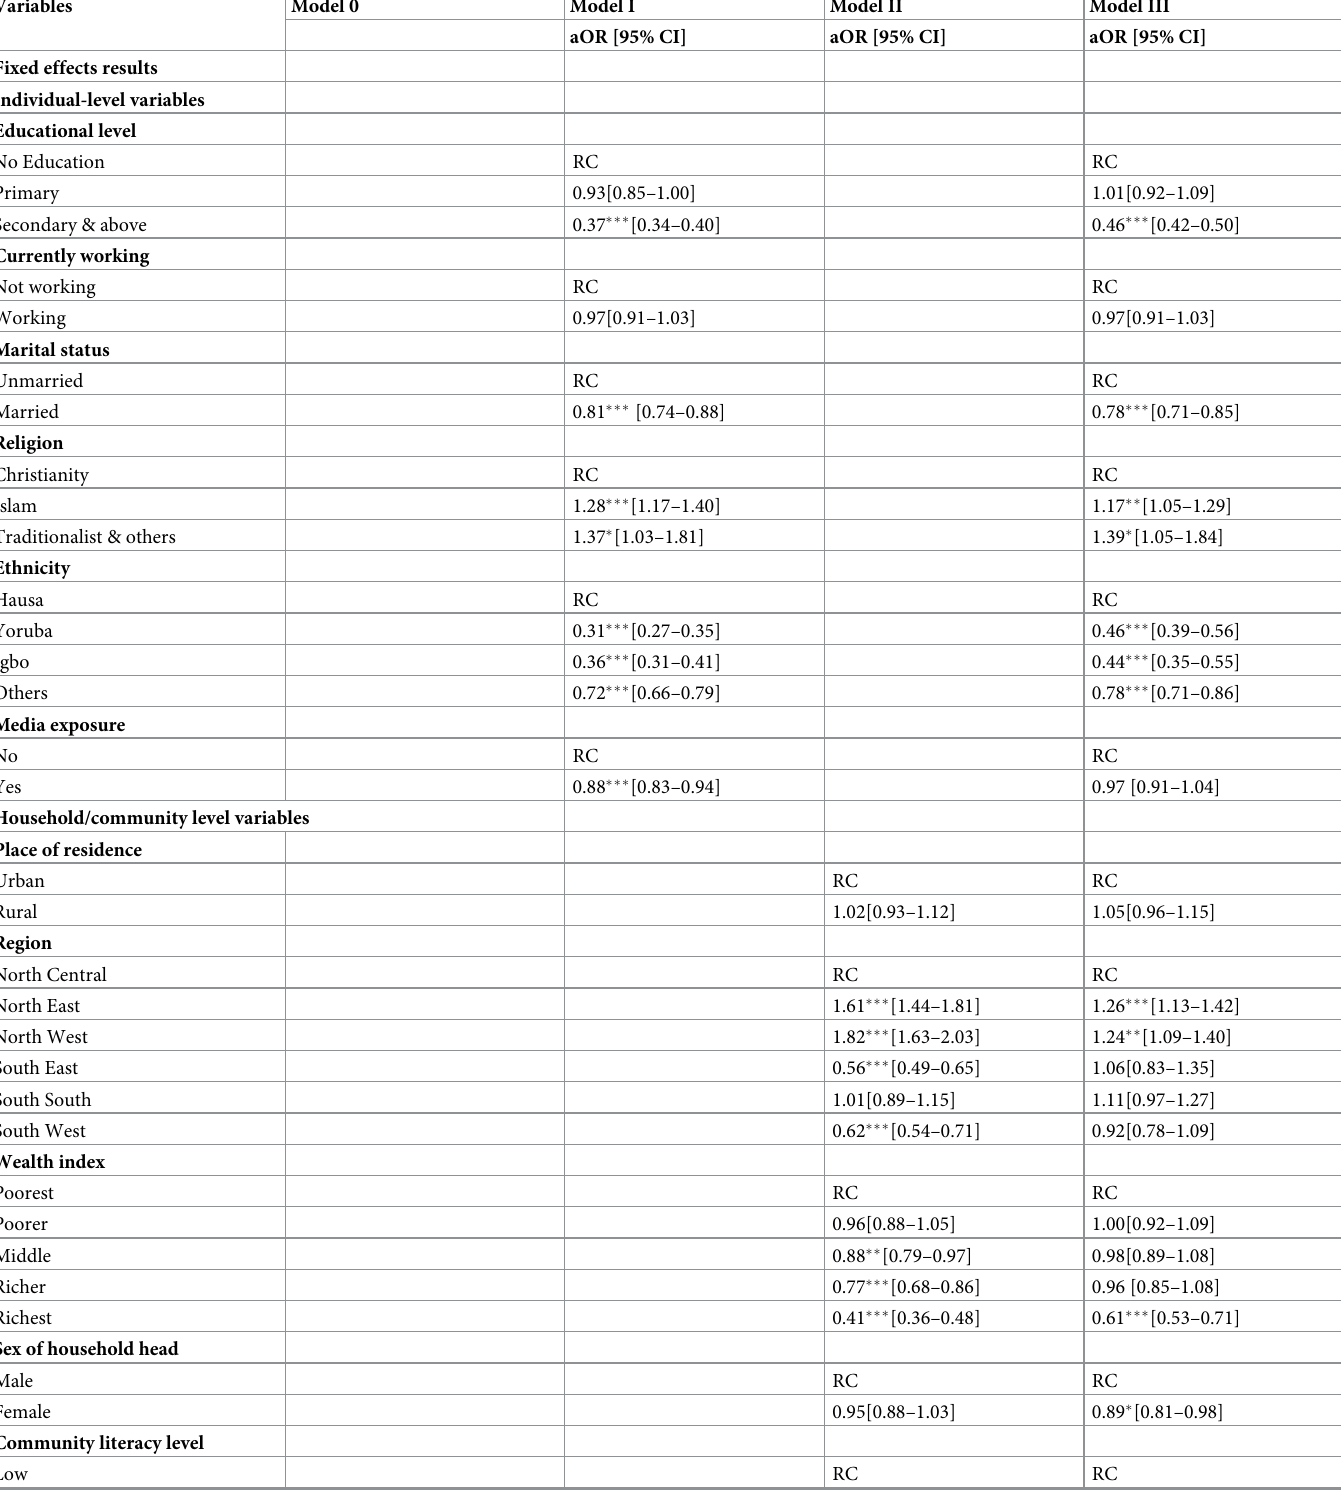
Table 2. Multilevel logistic regression models for individual and household/community predictors of maternal age at first